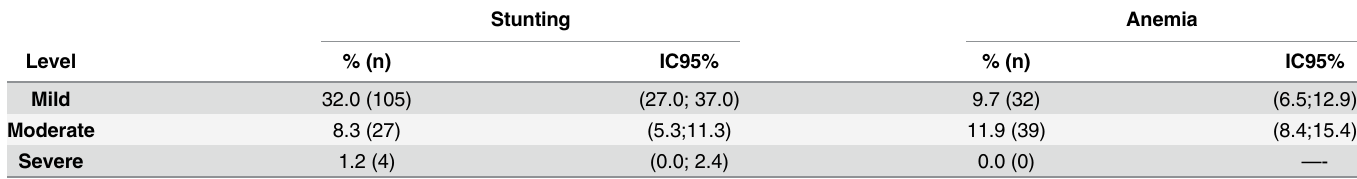
Table 4. Level of stunting and anemia (n = 328): relative frequencies (%), absolute frequencies (n) and confidence intervals of 95%